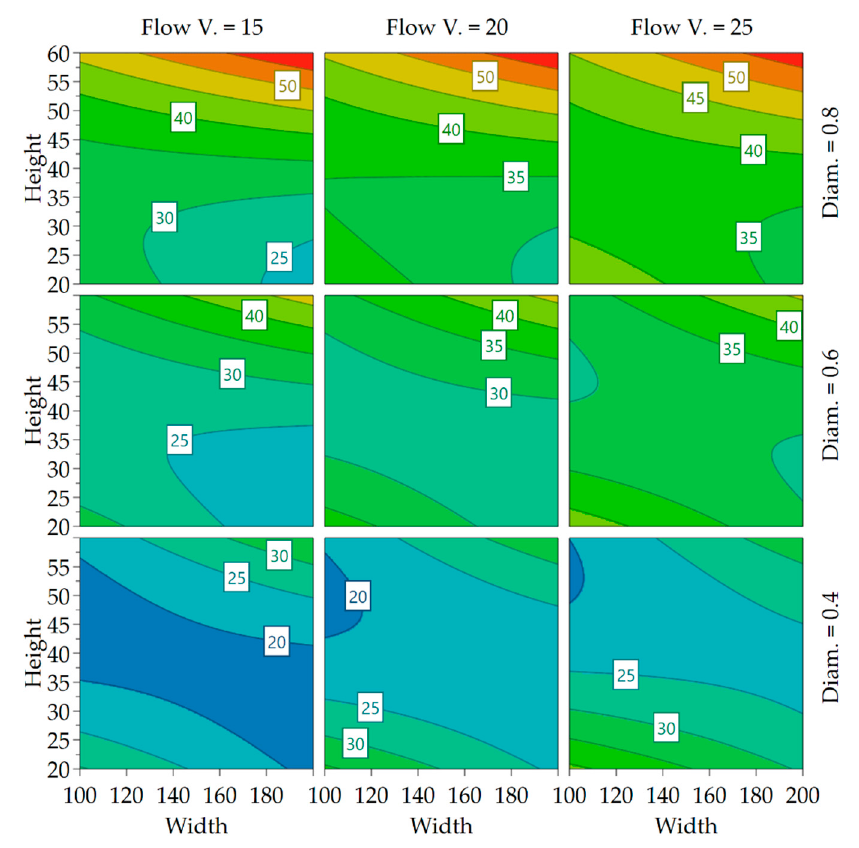
Figure 7. 4D contour plot of surface roughness.